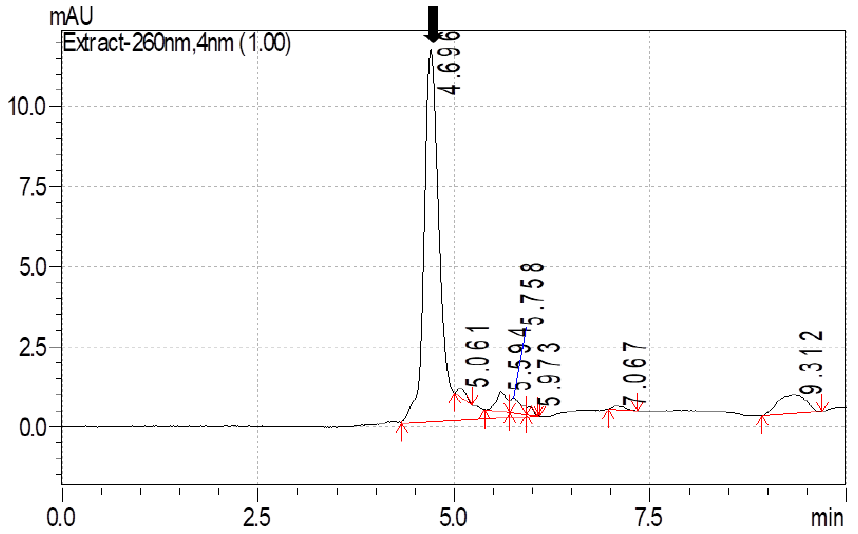
Figure 1. Chromatogram of amitraz recovered from the blood following fortification with a known quantity.